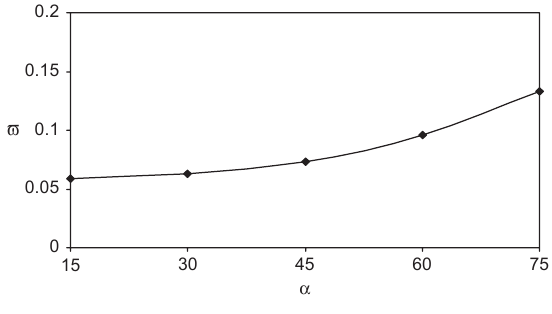
Effect of skew angle on the optimum fundamental